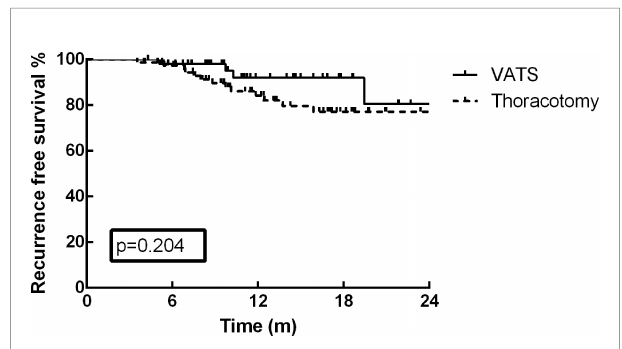
FIGURE 1 | No survival difference was identi fi ed between the different surgical approaches (p=0.204).